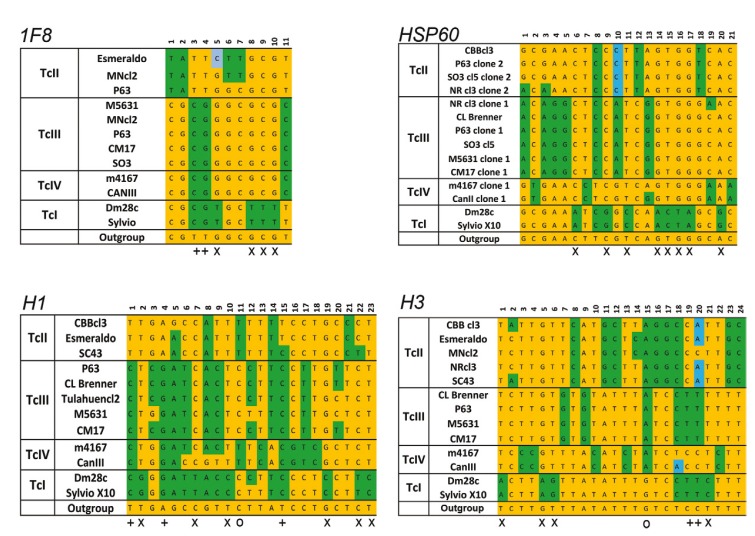
apparent mosaic patterns observed by Westenberger et al. (2005). Polymorphic sites for 1F8
calcium-binding protein, histone H1, histone H3 and heat-shock protein 60
(HSP60) loci analysed by Westenberger et al.
(2005) plus the outgroup sequences. Coloured columns show polymorphic
sites with information on clustering of different strains (only
parsimony-informative sites are shown). Green bases represent a derived
character, whereas yellow bases indicate an ancestral feature. Note that
excluding the outgroup, the sites marked with an X wrongly appear to cluster
TcIII and/or TcIV with TcII. In contrast, positions denoted with + show
clustering of TcIII and/or TcIV with TcI according to the outgroup. Positions
denoted with an "o" are clustering TcIV and/or TcIII with TcII. In consequence,
excluding the outgroup gives an apparent mosaic which is not real.